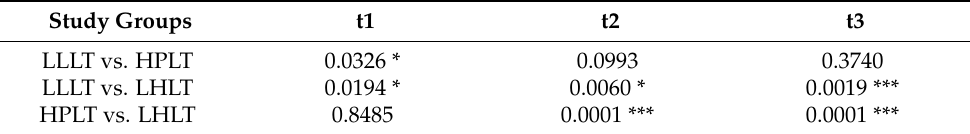
Table 3. Comparison of the mean values of VAS estimated at t1, t2, and t3 for the three pairs of study groups: LLLT vs. HPLT, LLLT vs. LHLT, and HPLT vs. LHLT. * = p -value < 0.05; *** = p -value < 0.005. LLLT: Low-Level Laser Therapy; HPLT: High-Power Laser Therapy; LHLT: Low–High combined Laser Therapy; CW: Continuous